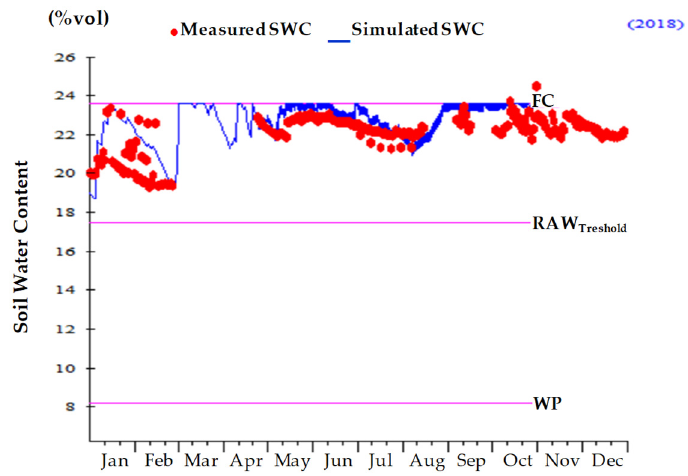
Figure 4. Soil water content (expressed in volumetric fraction) simulated by the ISAREG model (blue line) vs. soil water content data observed by the capacitive probe (red dots) for the 2018 irrigation season (FC—field capacity, WP—permanent wilting point, RAW Threshold —threshold for the readily available